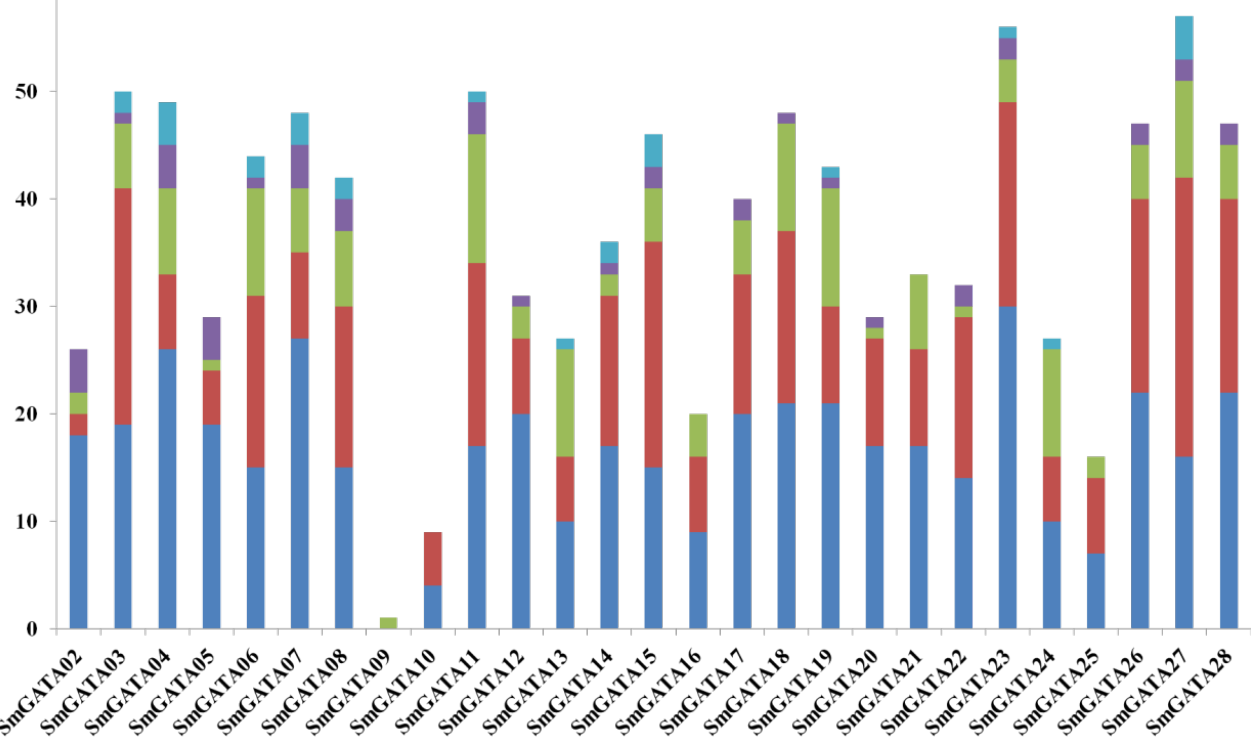
Figure 5. Cis-acting regulatory element analysis of SmGATA genes.